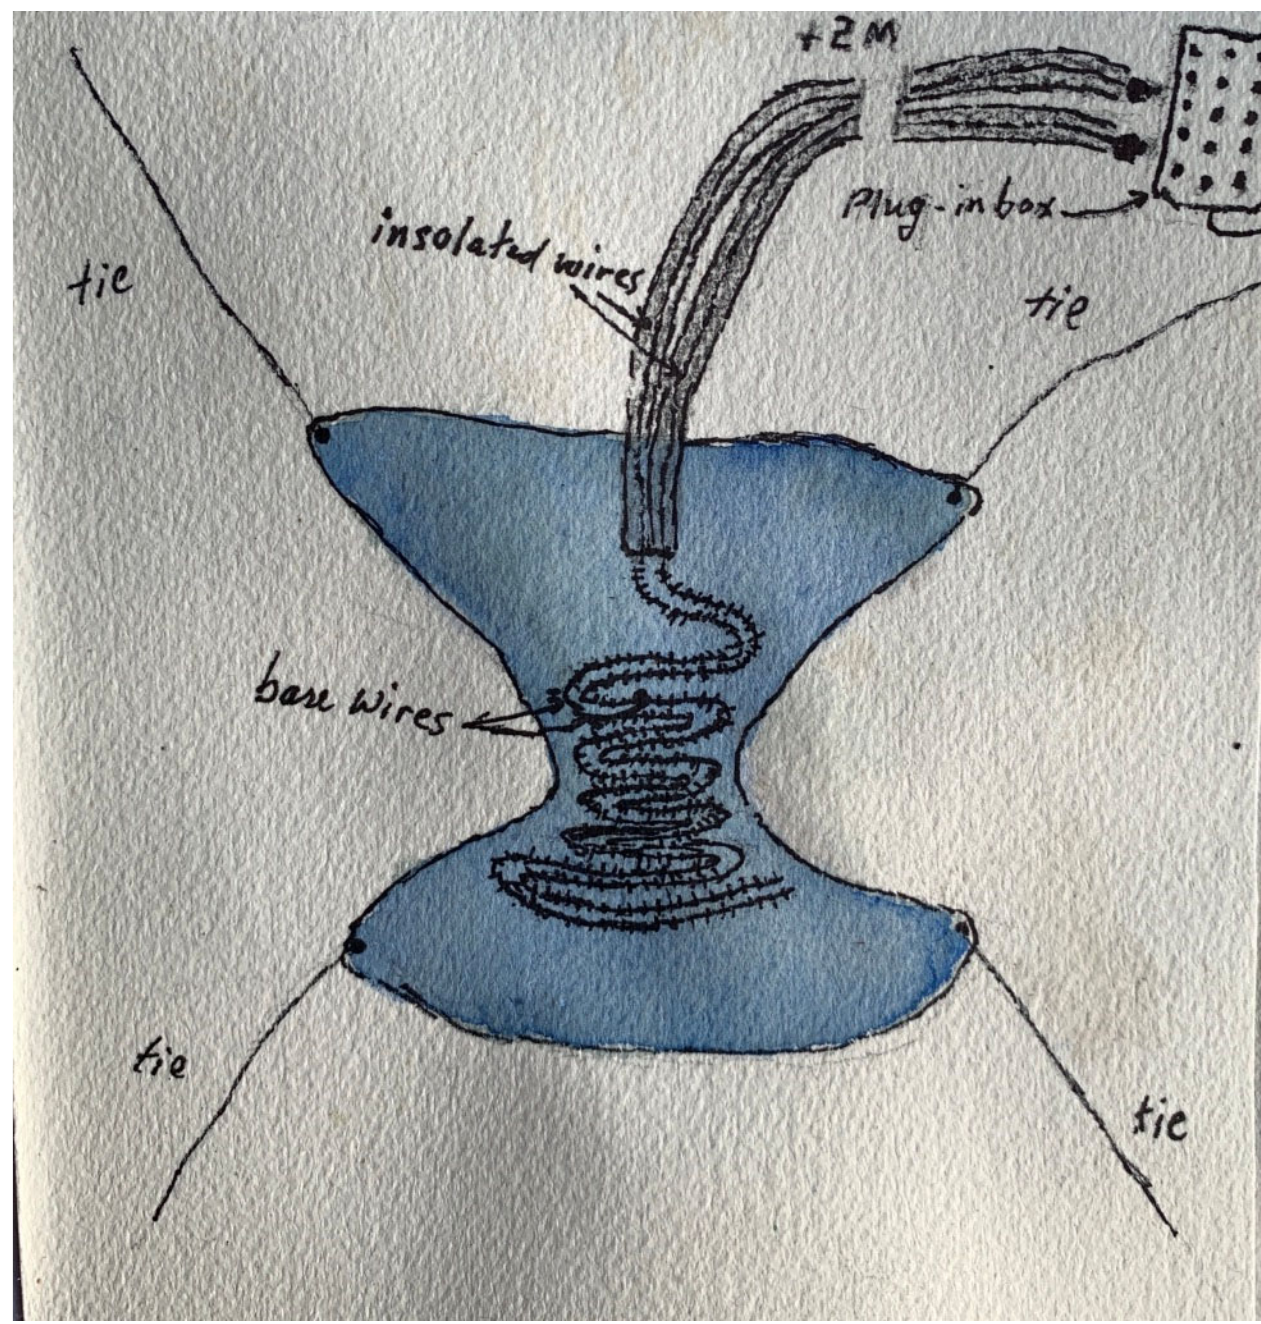
Figure 2. The bikini for the detection of the precise moment of the onset of enuresis was designed by Roger Broughton and manufactured by his wife Joan. Two electrode wires with insulation removed and with the bare wires were sewn close together in serpentine fashion in the crotch area of the bikini. A few drops of urine on the bikini caused a short ‐ circuit between the wires and the 50 Hz mainline artifact become a fine line. The ties were tied just above the hips (unpublished personal photo of the author).